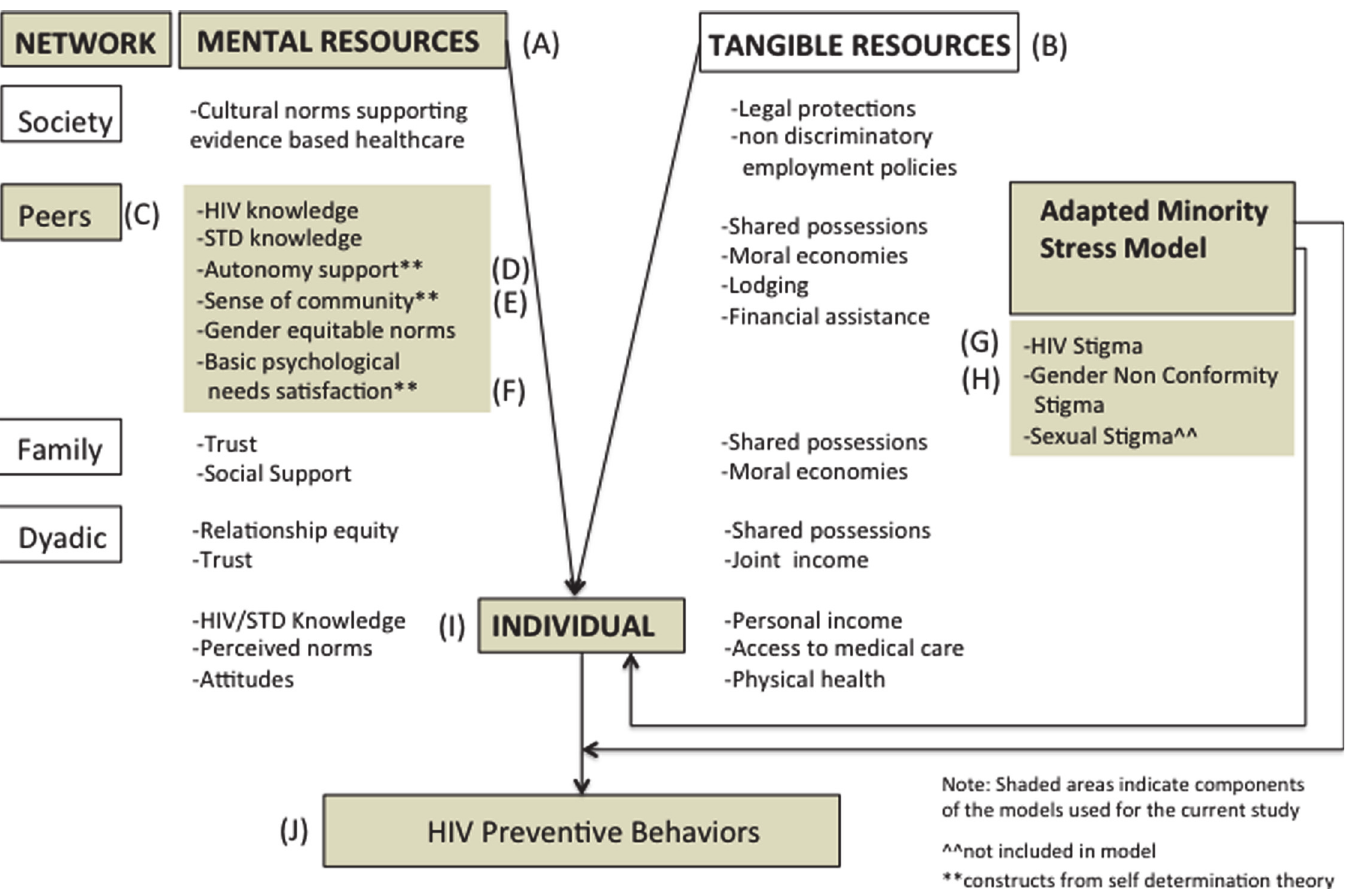
Figure 1. Integrated network-individual-resources (NIR), self-determination theory (SDT), and adapted minority stress framework. The (A) mental and (B) tangible HIV prevention resources that are in operation at the (C) peer network-level are theorized to influence (I) individuals and their enactment of (J) HIV preventive behaviors. The SDT concepts of (D) autonomy support, (E) sense of community and (F) basic psychological needs satisfaction are peer network-level mental resources within the NIR model. Within this integrated framework, (G) HIV stigma intersects with (H) gender non-conformity stigma to directly influence the (I) individual and also to moderate the influence of peer-network level mental resources on the individual ’ s (J) HIV preventive behavior.